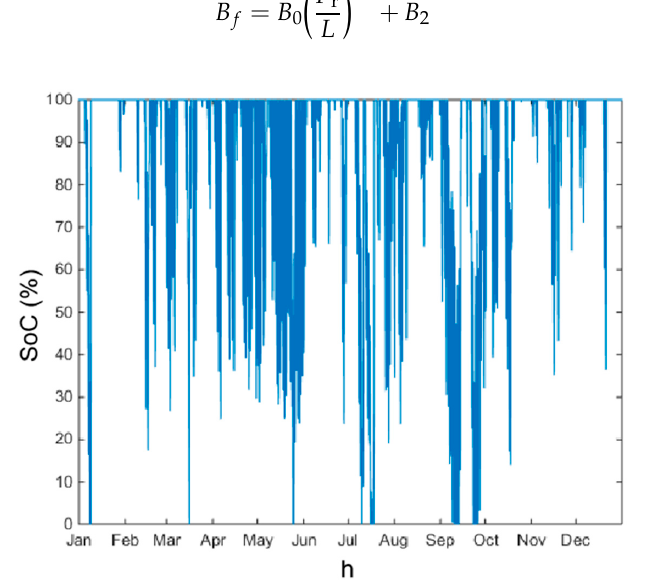
Figure 2. Temporal variation of the State of Charge (SOC) in a year.